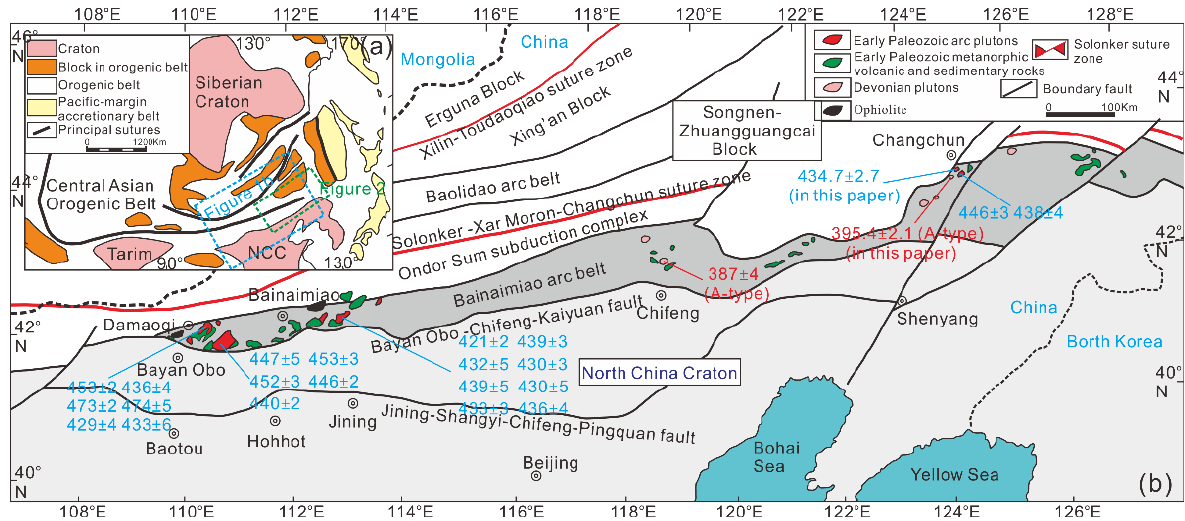
Figure 1. ( a ) Simplified tectonic sketch map of the southeastern CAOB and ( b ) the northern margin of the Northeast China block. Age data and references presented in supplementary material Table S1.